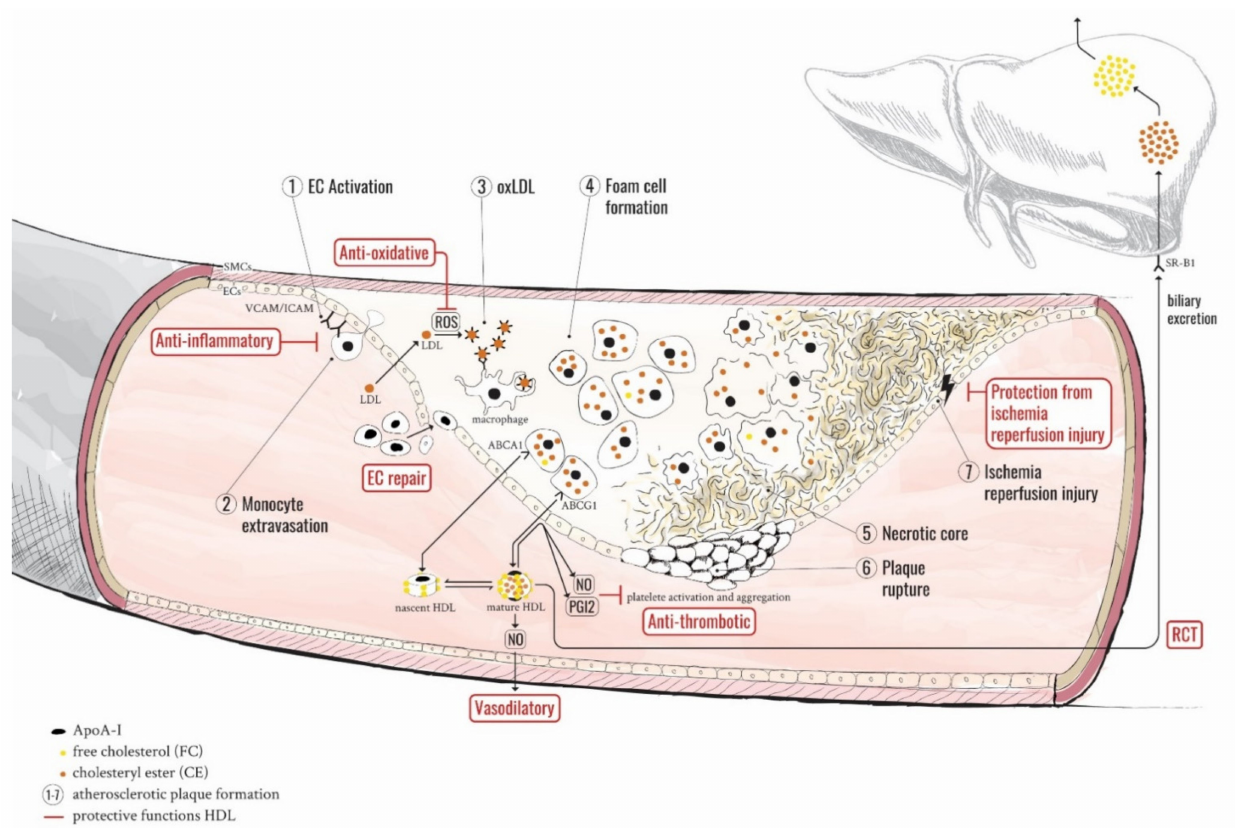
Figure 1. The stepwise development of atherosclerosis and the protective interference of